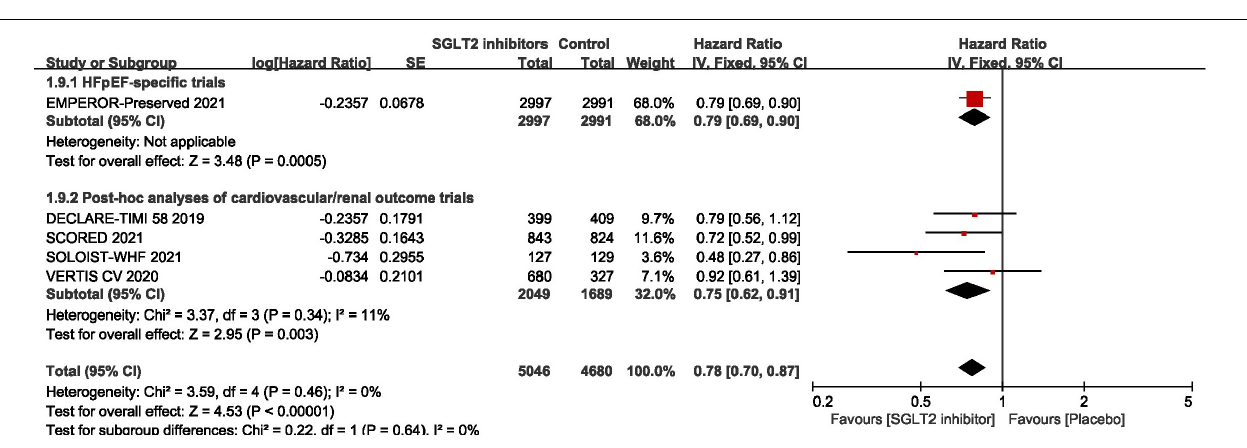
E/e’ The ratio of early mitral inflow velocity to mitral annular early diastolic velocity was expressed in mean and standard deviation in two trials (46, 48). Pooled result demonstrated that